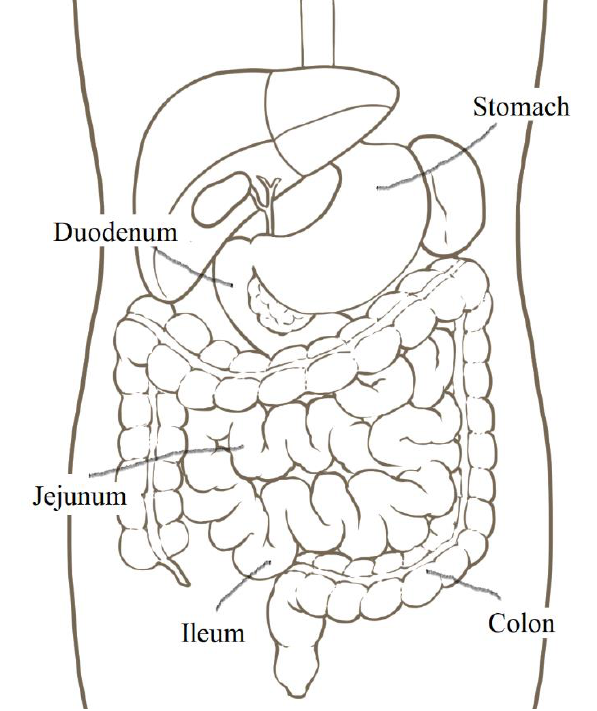
Figure 1. The position of digestive organs.